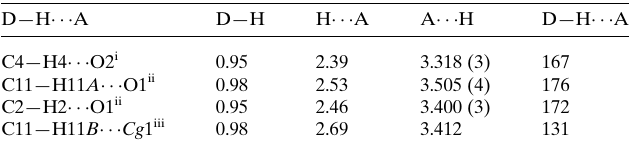
Table 1 Hydrogen-bond geometry (A˚ , (cid:6) ) for (I). Cg 1 is the centroid of the C1–C6 ring.